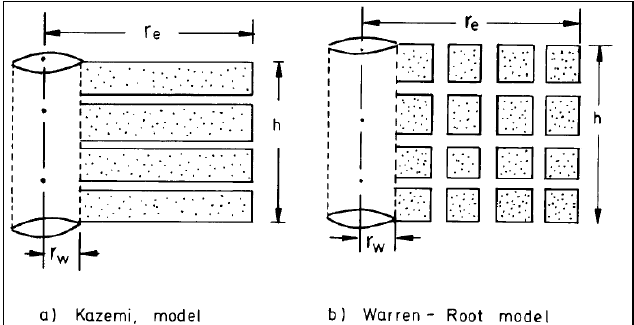
Figure 6. The idealized models for naturally fractured reservoirs[20]